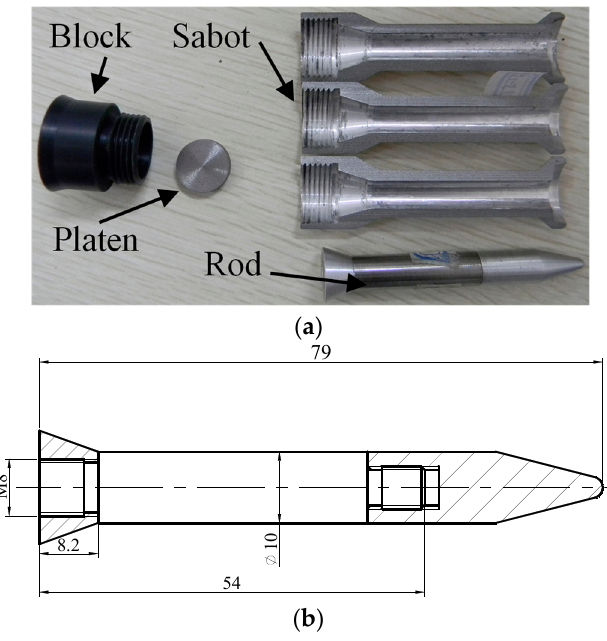
Figure 2. ( a ) Expanded view of projectile and ( b ) dimensions of rod. Projectiles are launched by Ø25 mm smooth bore artillery. The setup of experiments is shown in Figure 3. An RHA target with a thickness of 80 mm is placed 10 m in front of the artillery. A laser doppler anemometer is used to measure the velocities of the rods. The impact velocities of the rods vary from 1470 m/s to 1650 m/s.